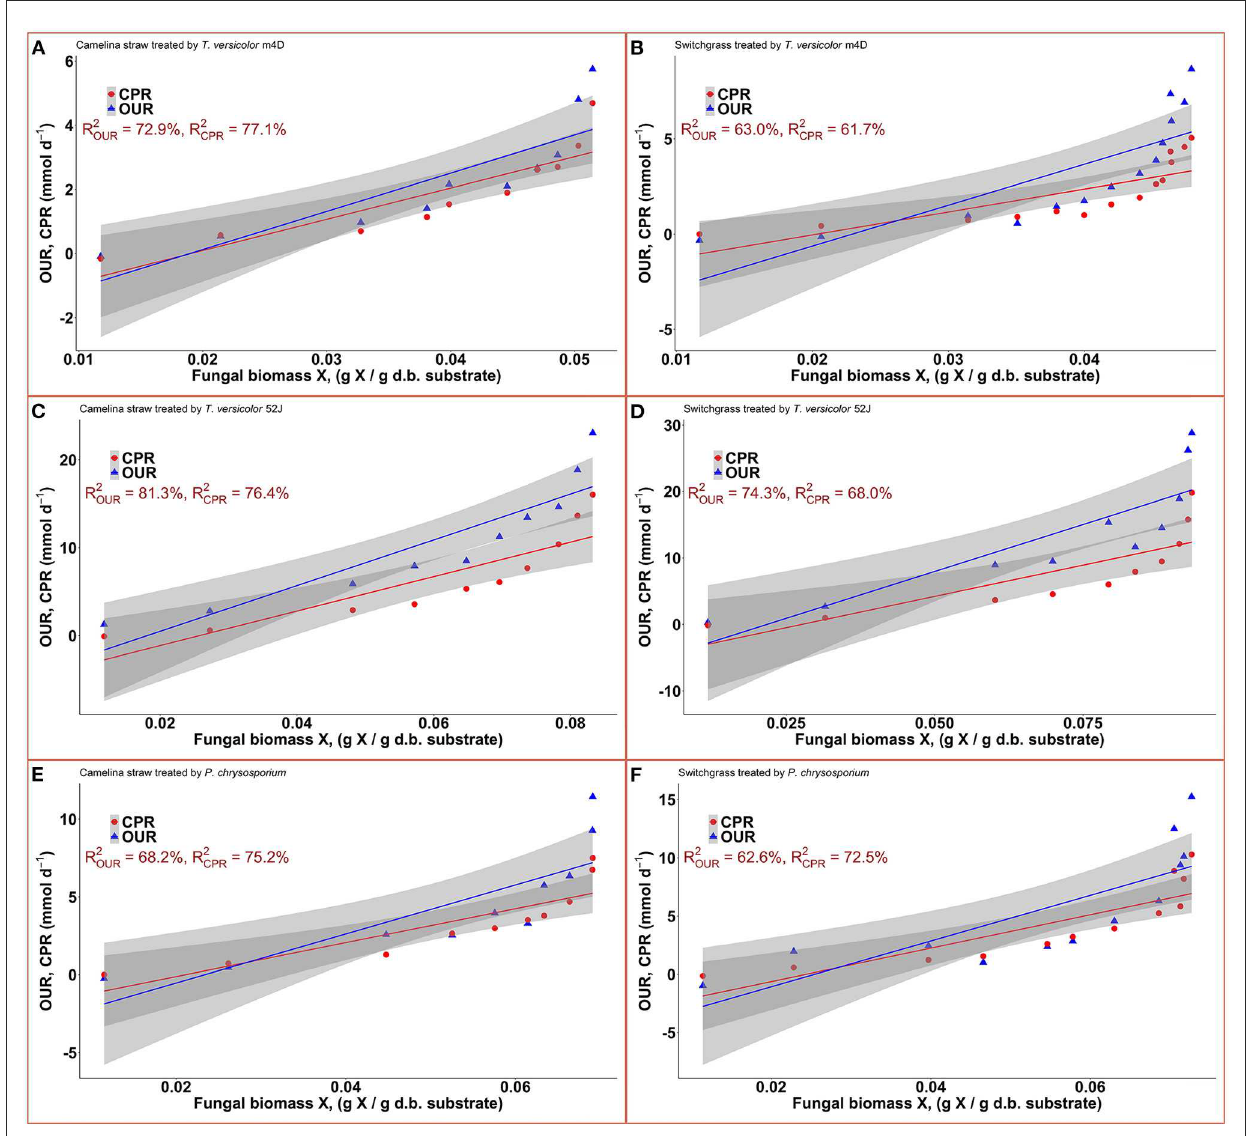
FIGURE7 Correlation between fungal biomass content and OUR, CPR: (A) : TVm4D on CS, (B) : TVm4D on SG, (C) : TV52J on CS, (D) : TV52J on SG, (E) : PC on CS, (F) : PC on SG. OUR, oxygen uptake rate; CPR, carbon dioxide production